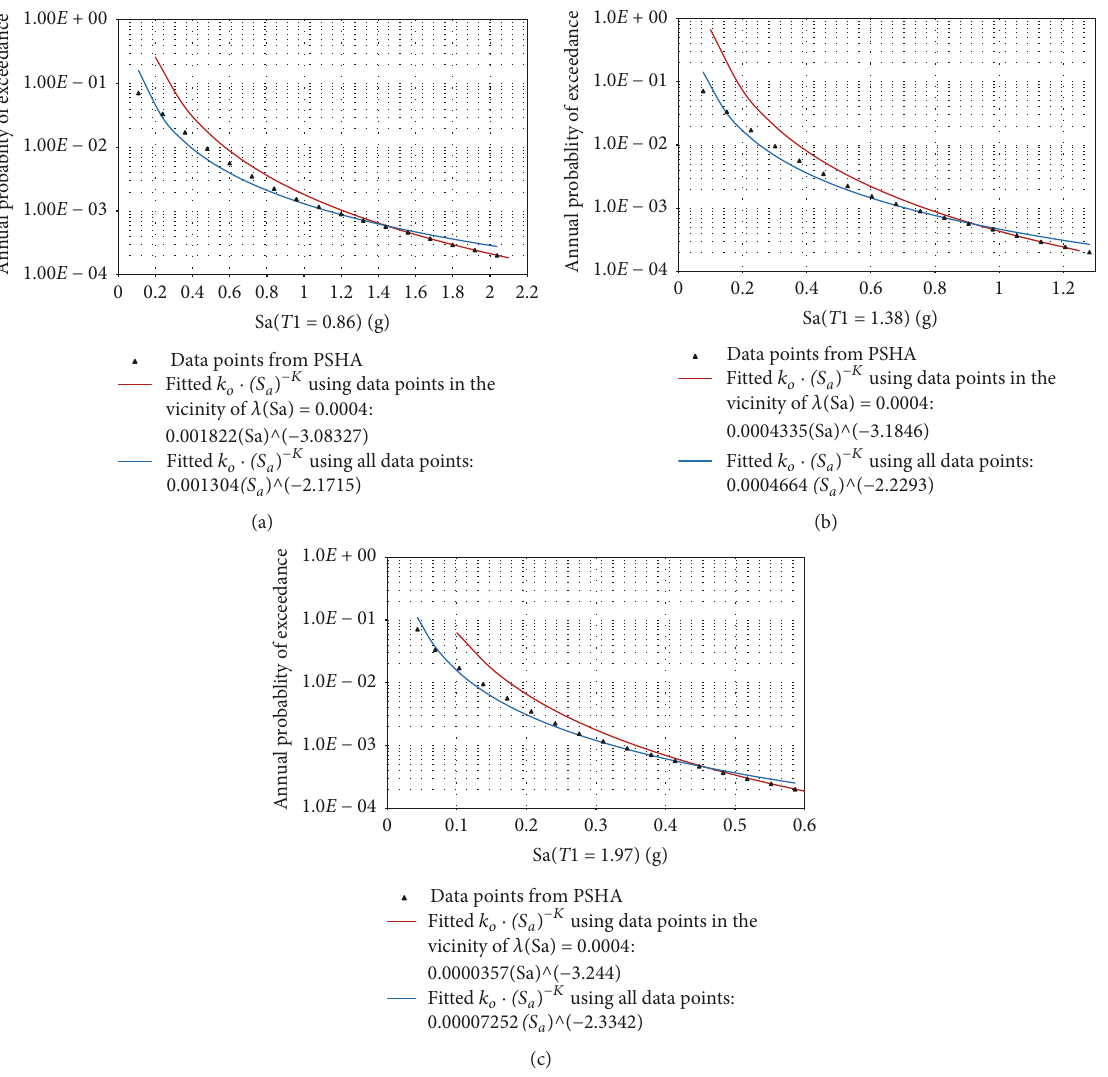
Figure 8: Seismic hazard curve for the location: (a) period ( 𝑇1 = 0.86 sec) of the 6-story building, (b) period ( 𝑇1 = 1.38 sec) of the 12-story building, and (c) period ( 𝑇 1 = 1.97 sec) of the 18-story